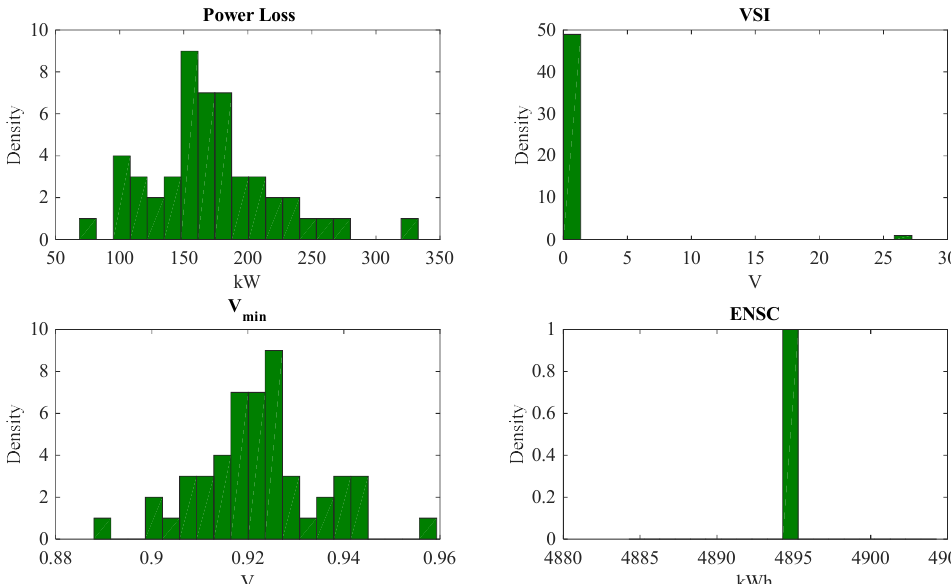
Figure 6. PDF of base results of 33-bus network based on SMM.